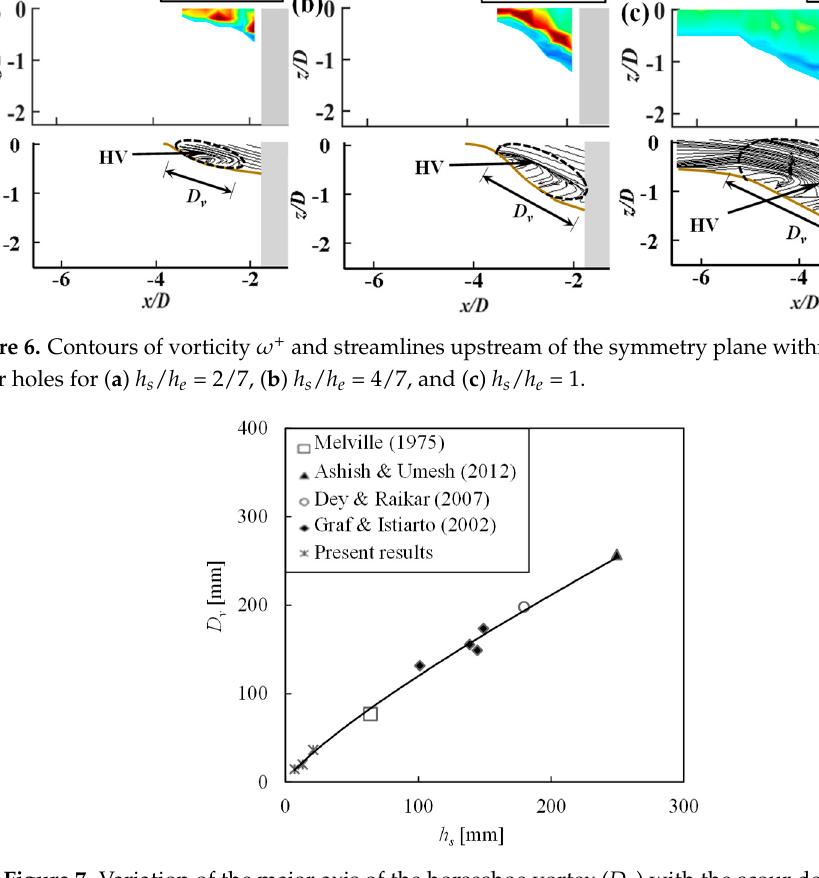
Figure 7. Variation of the major axis of the horseshoe vortex ( D v ) with the scour depth ( h s ) .